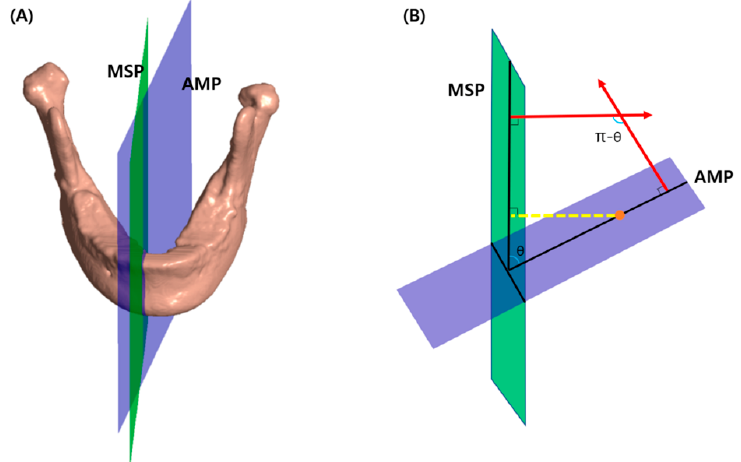
Figure 3. Procedure for calculating the distance and angle between the facial midsagittal plane (MSP) and absolute mandibular midsagittal plane (AMP). ( A ) MSP and AMP; ( B ) The angle formed by two normal vectors of MSP and AMP is the same as the angle between the two planes. The distance between MSP and the center (orange dot) of Me, B, and G in the absolute mandibular midsagittal plane (AMP) is shown with the yellow dotted line.